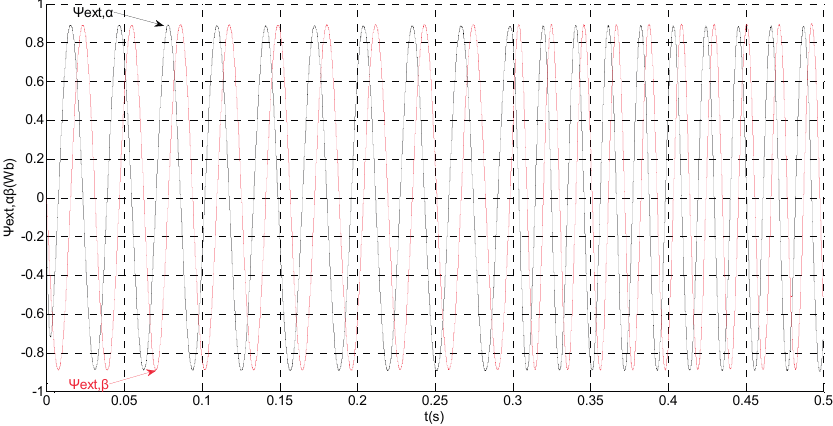
Figure 16. Simulation results of the observation of extended flux